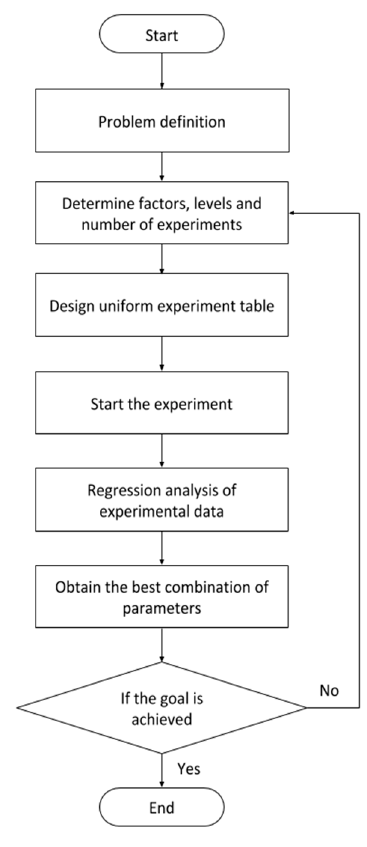
Figure 4. Uniform experimental design (UED) method flow.